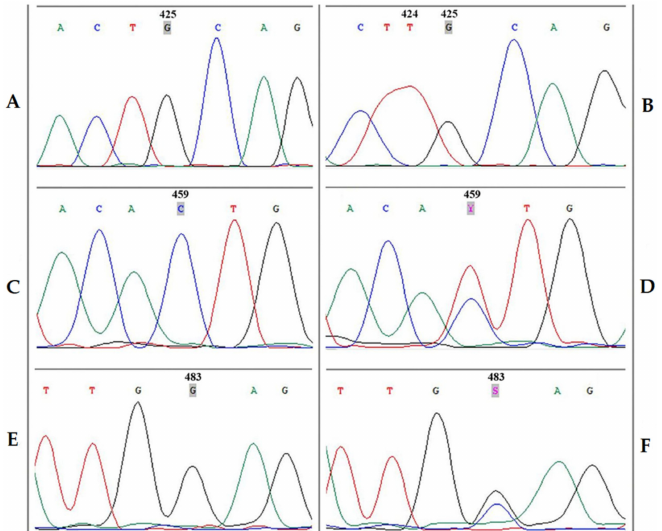
Figure 9. Detection of polymorphic positions (424/425/459/483) of the Vitis vinifera L. UFGT gene locus by capillary Sanger sequencing method. Legend: ( A ) position 425 (G); ( B ) position 424 ( T ) and 425 (G); ( C ) position 459 (C); ( D ) position 459 (Y); ( E ) position 483 (G); ( F ) position 483